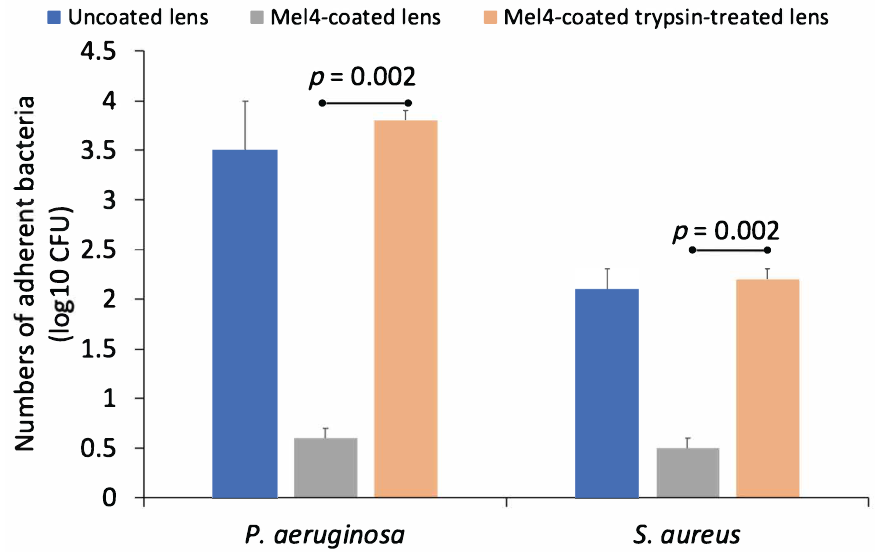
Figure 4. Effect of trypsin treatment on the numbers of S. aureus cells adhering to contact lenses coated with Mel4.